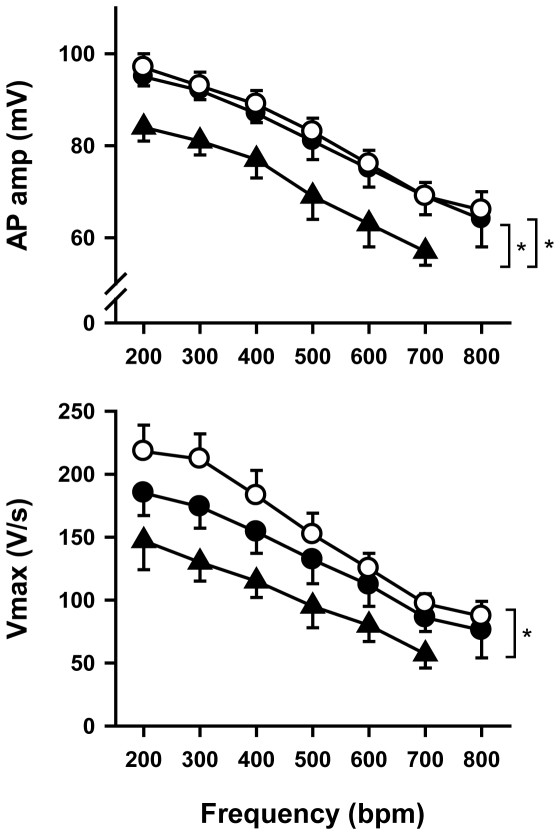
Action potential amplitude (AP amp; top) and maximum upstroke velocity (Vmax; bottom) as a function of pacing frequency.White circles, wild type mice (n = 7); black circles, Scn5a
+/− mice with a mild phenotype (n = 6); black triangles, Scn5a
+/− mice with a severe phenotype (n = 5). At 800 bpm, 4 preparations from Scn5a
+/− mice with a severe phenotype were periodically (for 1 of them) or continuously (for the 3 others) in 2∶1 conduction block. *, p<0.05.